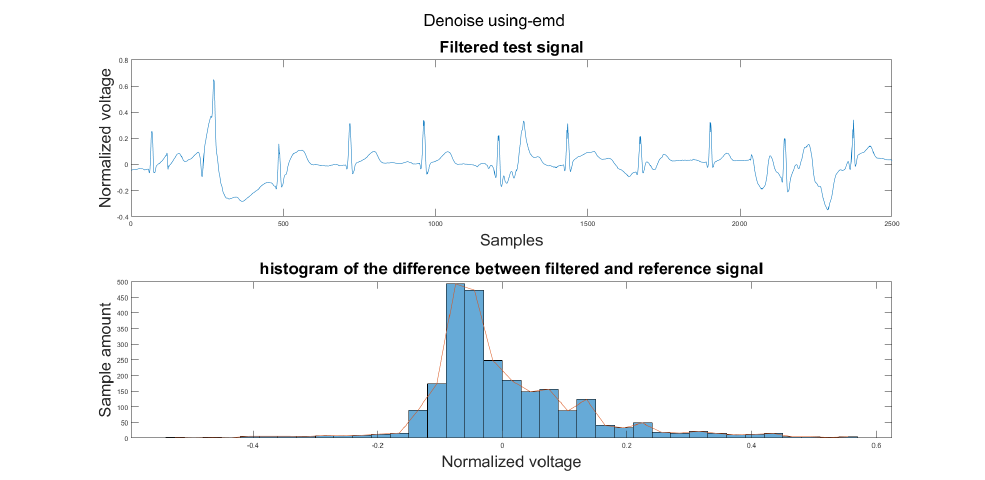
Figure A40. (1) Test signal, (2) histogram of the difference.